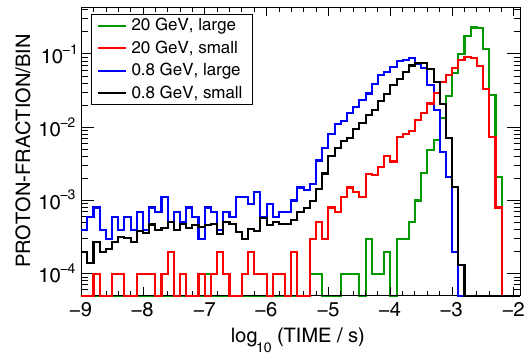
FIG. 7. The distribution of the total time period that all neutrons produced by a single proton spend inside the ion beam pipe for a moderator 1 m in radius and all target/beam combinations listed in Table II and the discussion of Eq. (1). The x-axis has a logarithmic binning with ten bins per time